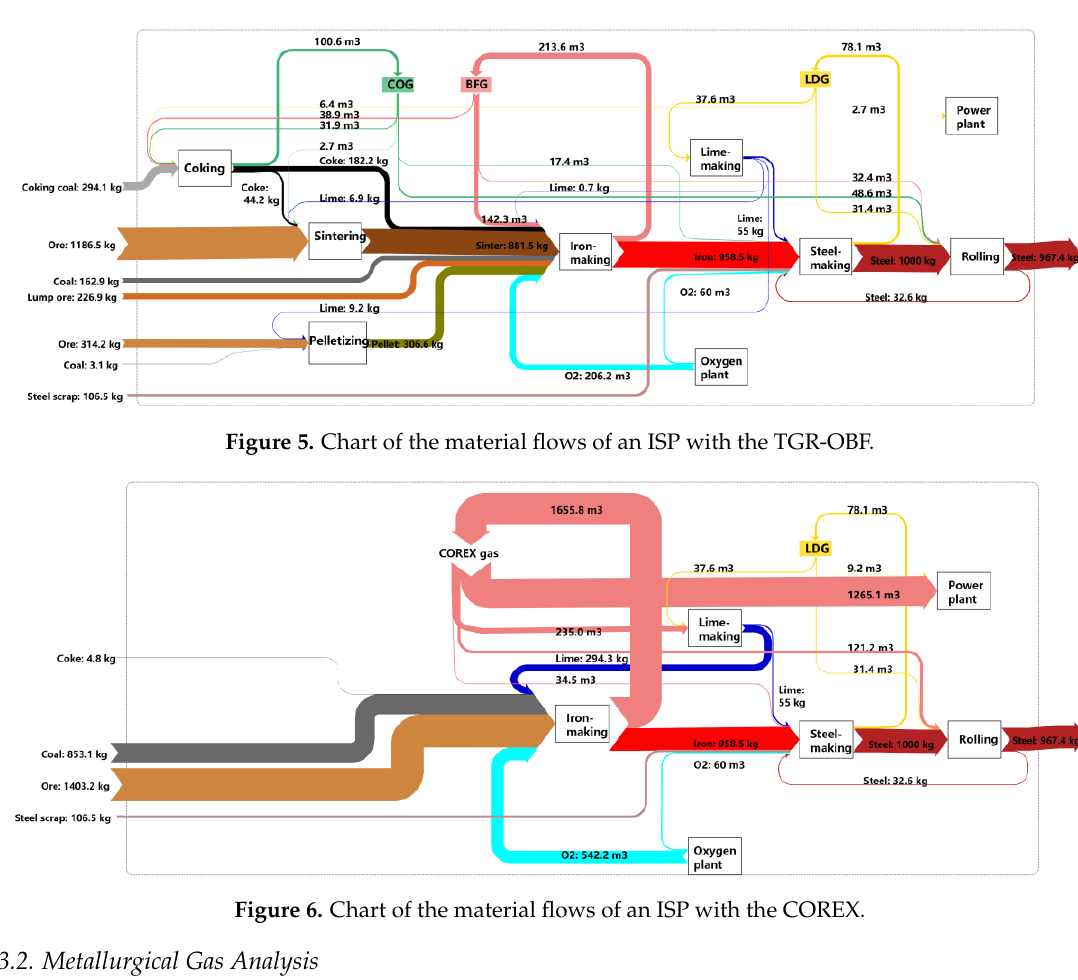
Figure 4. Chart of the material flows of a conventional ISP.